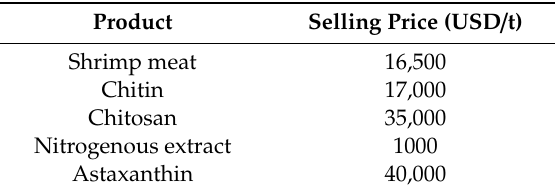
Table 3. The selling price of products.